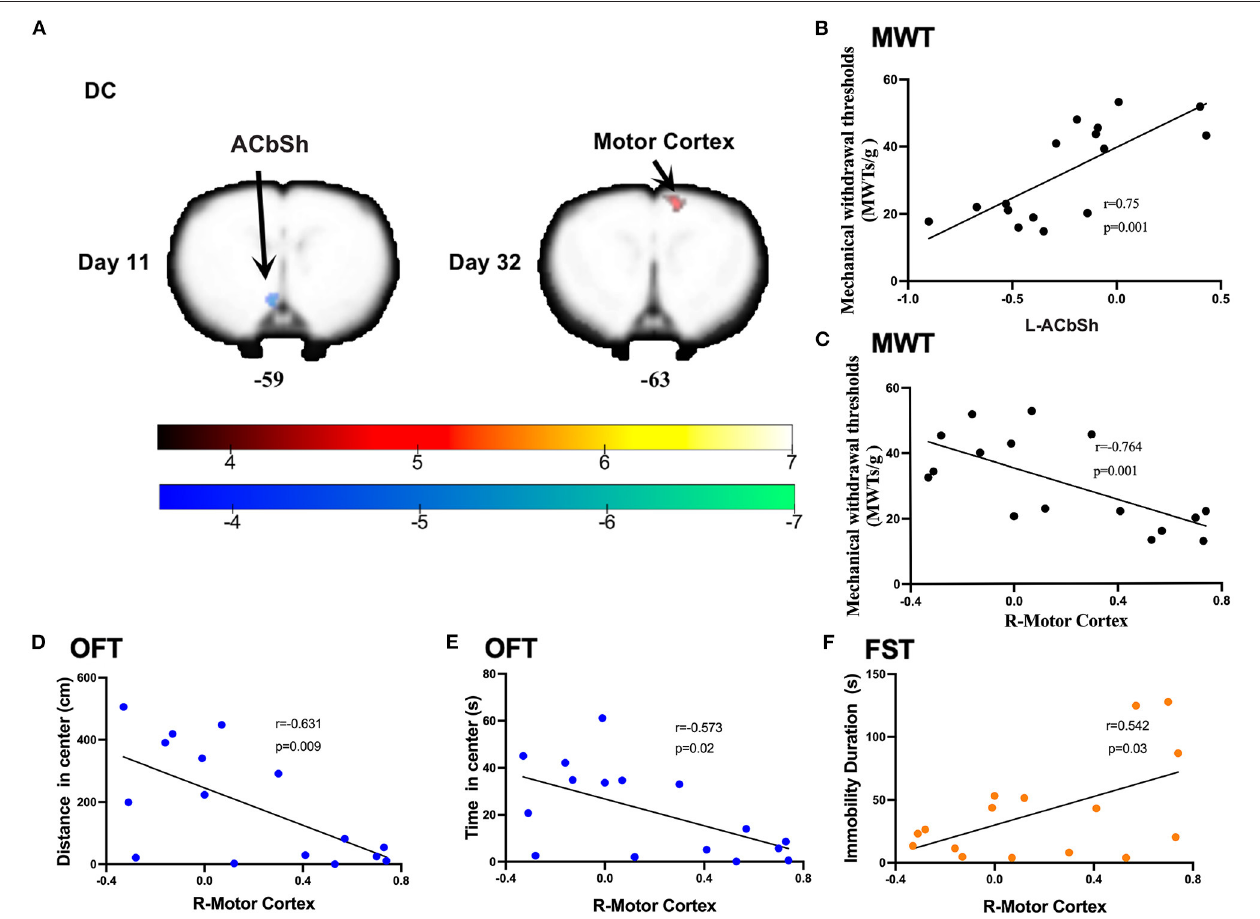
FIGURE 5 | Significant DC alternations induced by CCI and correlations between DC values and the mechanical withdrawal thresholds (MWT), open field test (OFT), and forced swimming test (FST) data. (A) CCI group rats exhibited significantly lower DC values in the left nucleus accumbens shell (ACbSh) on day 11 after CCI surgery and significantly higher DC values in the right motor cortex on day 32 after CCI surgery as compared to sham rats; (B) DC values in the ACbSh (10 days after CCI surgery) positively correlated with MWT values (7 days after CCI surgery); (C–E) DC values in the right motor cortex (32 days after CCI surgery) negatively correlated with MWT values (28 days after CCI surgery), distance traveled and time spent in the central zone of OFT (29 days after CCI surgery); (F) DC values in the right motor cortex (32 days after CCI surgery) positively correlated with the immobility time on FST (31 days after CCI